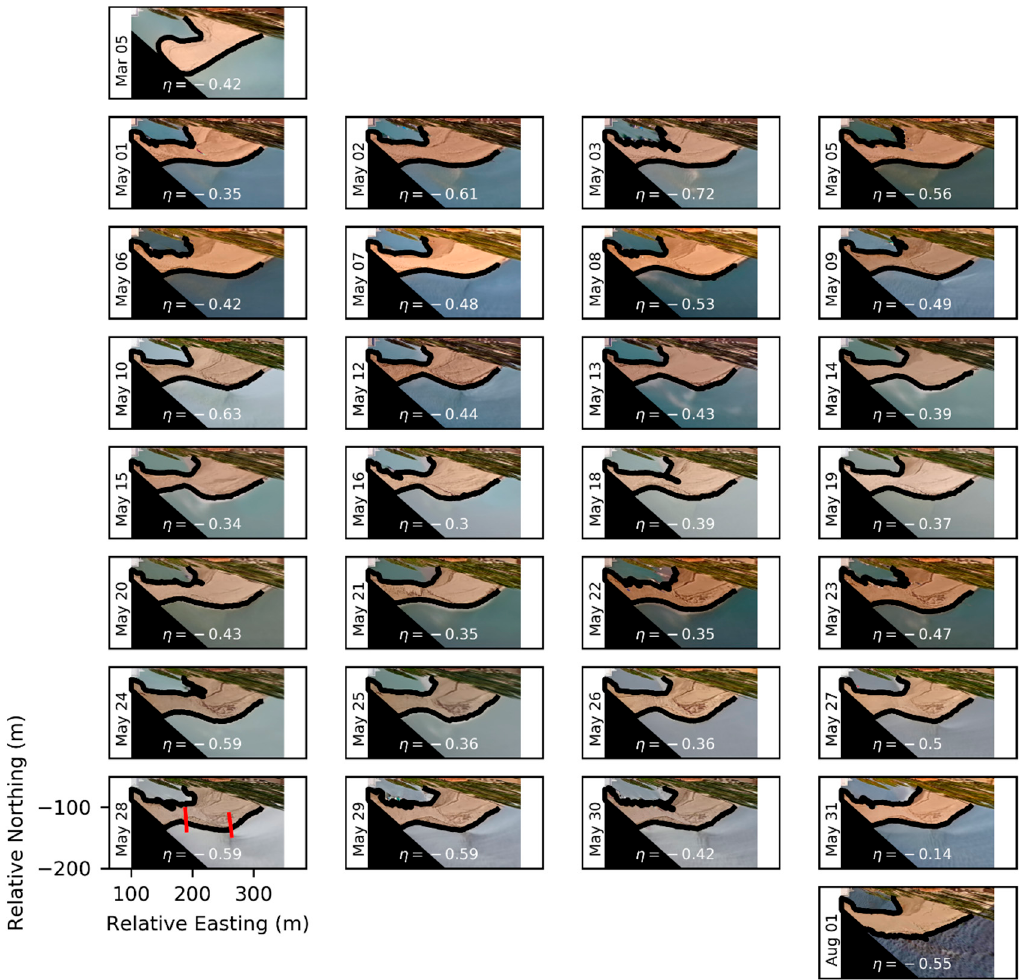
Figure 5. Spit shoreline maps derived from the St. Lucie camera. Water level of each timex is shown. Harley et al. [11] and Vos et al. [37] use the semivariogram as a method of quantita- tively assessing the typical timescales of variability in a shoreline signal relative to uncer- tainty in the observational technique. While we do not have the necessary data to quantify typical timescales of variability on this weir jetty spit with this method, we examined the observations of shoreline change over multiple timescales relative to the derived observa- tional uncertainty. Figure 6 shows water-level-corrected shoreline position changes at the two transects shown in Figure 5 (red transects on image in the lower left corner) relative to uncertainty. This is shown for changes between every observation as well as end-point changes over each of the four weeks of near-daily observations in May. Figure 6 reveals that the largest magnitude shoreline changes at both transects — a 12 m retreat between 31 May and 1 August at the eastern transect and a nearly 36 m retreat between 5 March and 1 May at the western transect in response to the large-scale spit reorientation visible in Figure 5 — are outside of uncertainty. However, none of the near-daily observations in May, as well as only one of the four weekly scale changes at the western transect and none at the eastern transect, are outside of uncertainty (Figure 6). Thus, the remotely calibrated surfcam produces observations that only have a useful precision for the largest magnitude shoreline changes. These large changes took place over timescales of 2–3 months.